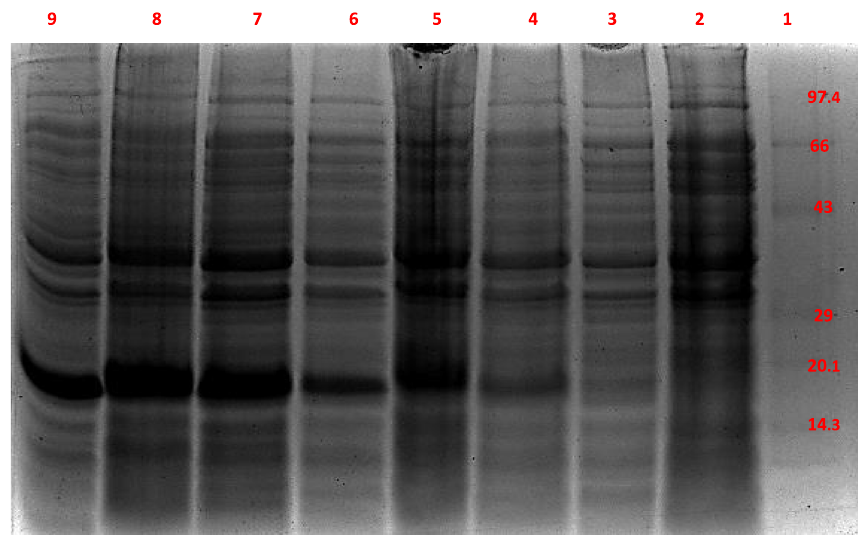
Fig. 11 Tricine SDS-PAGE analysis of the cells containing recombinantly expressed Thioredoxin tag (negative control), before and after IPTG induction on a time-course basis. Lane 1: Mid-range protein ladder; Lane 2: Uninduced control (before IPTG induction); Lanes 3–9: IPTG-induced cells after 0–6h of induction